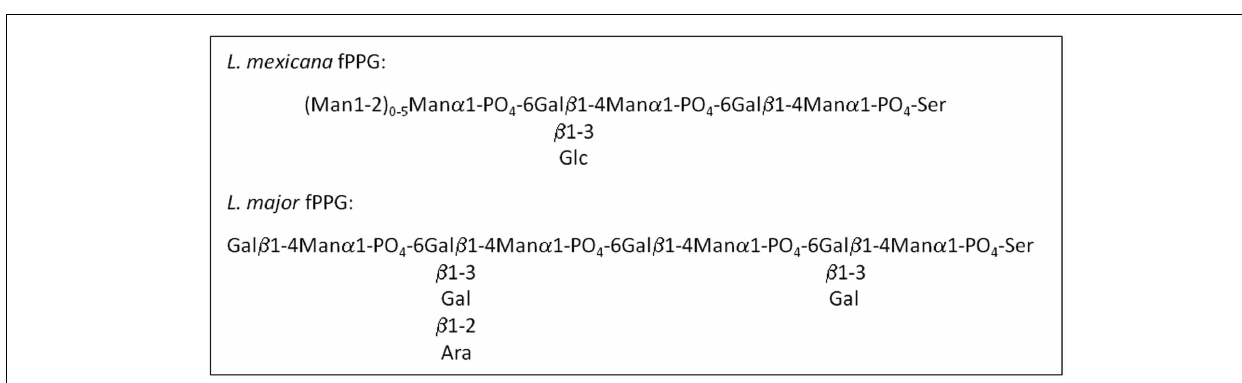
FIGURE 2 | Structure of Leishmania filamentous